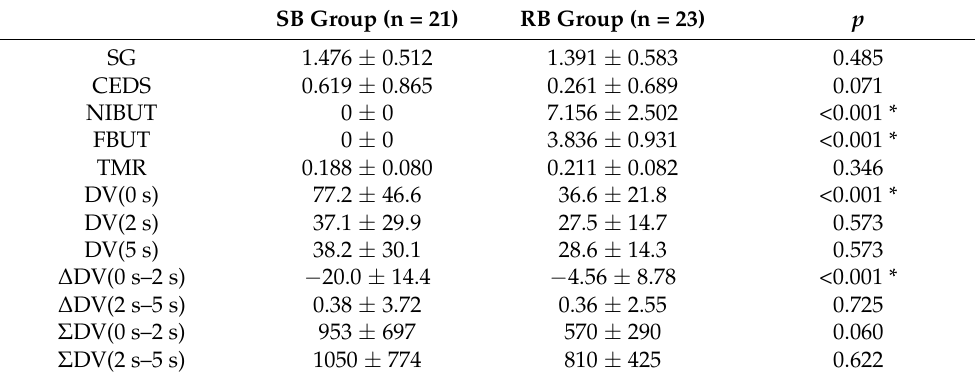
Table 2. Comparison of the OS abnormality and DV related parameters between the SB Group and RB